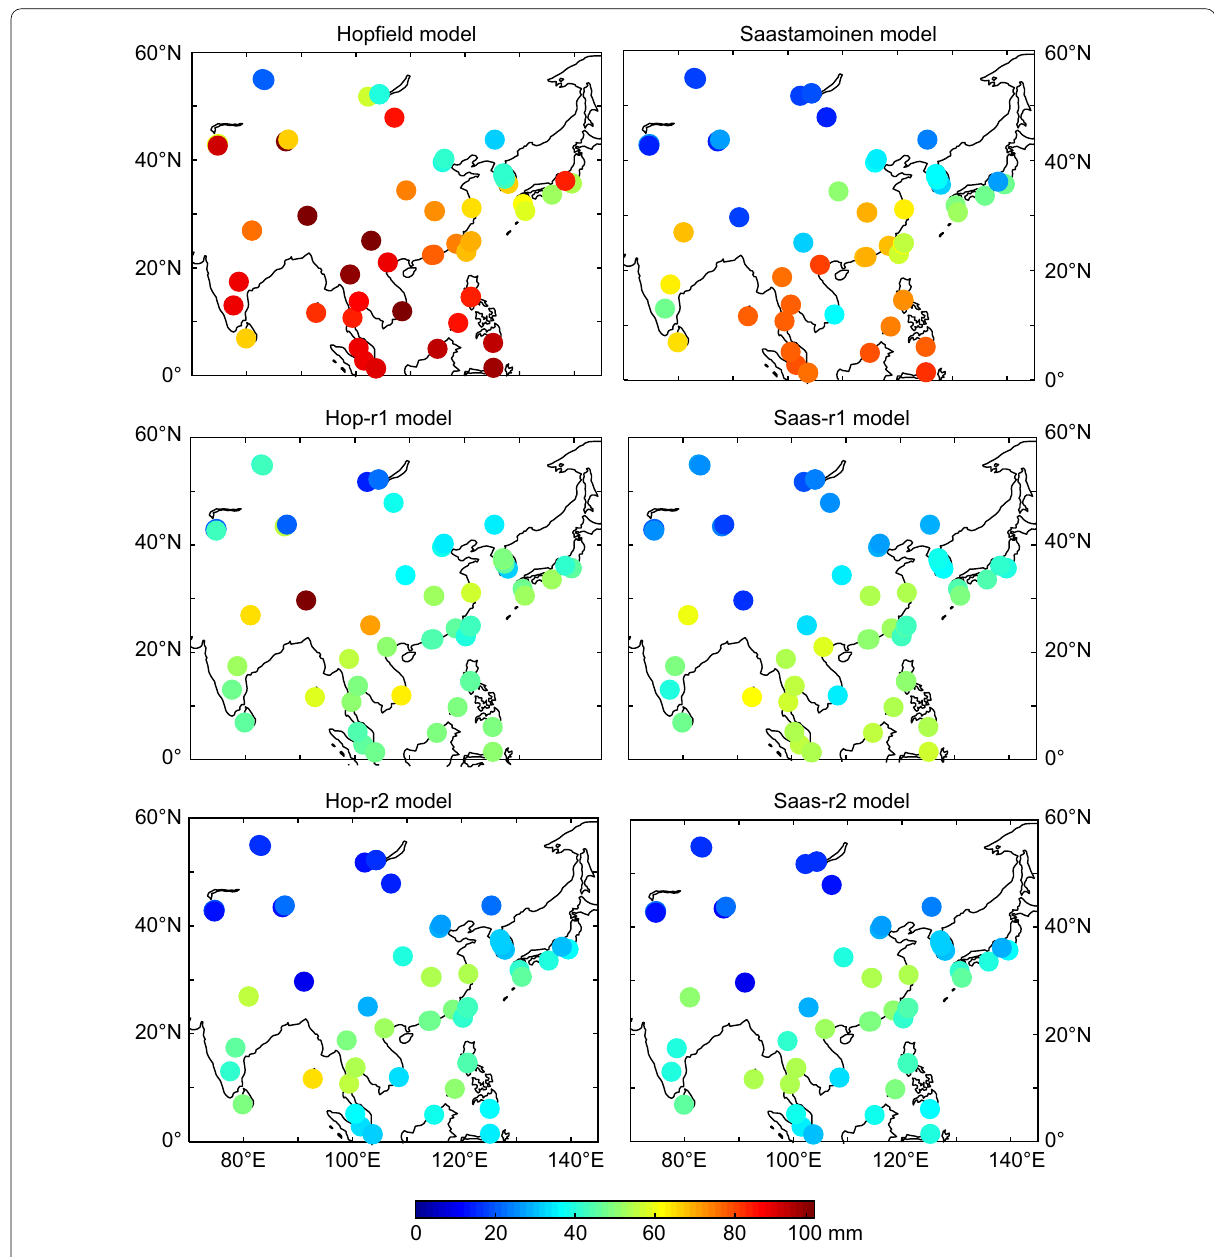
Fig. 2 Maps showing the RMSE at each site for the six